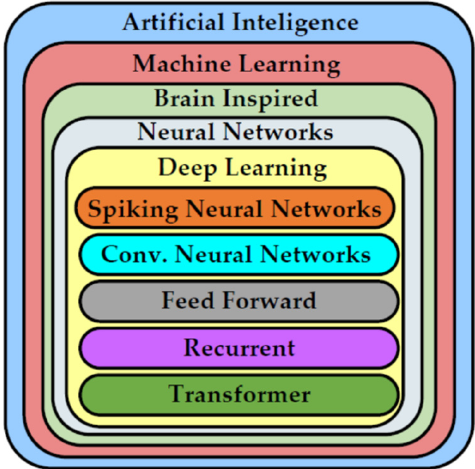
Figure 1. Taxonomy of AI and its sub-fields.